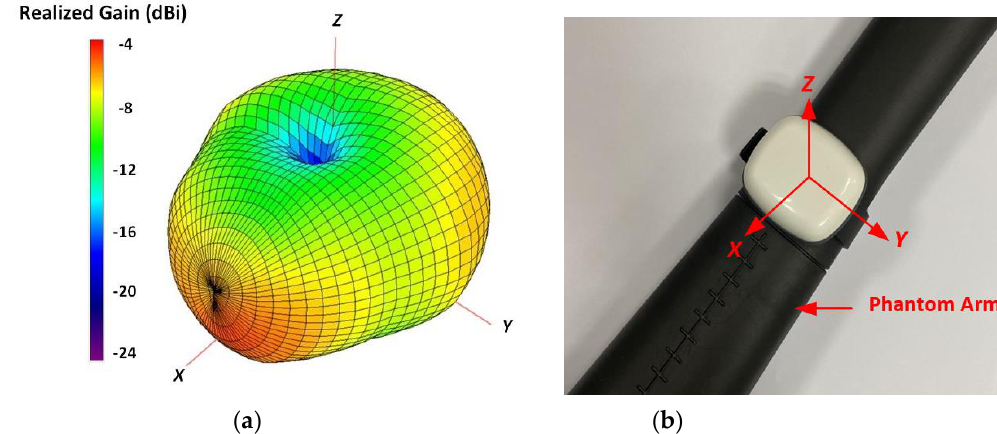
Figure 16. ( a ) Measured antenna realized gain (3D) at 868 MHz, ( b ) coordinate system of the wristwatch device placed on a phantom